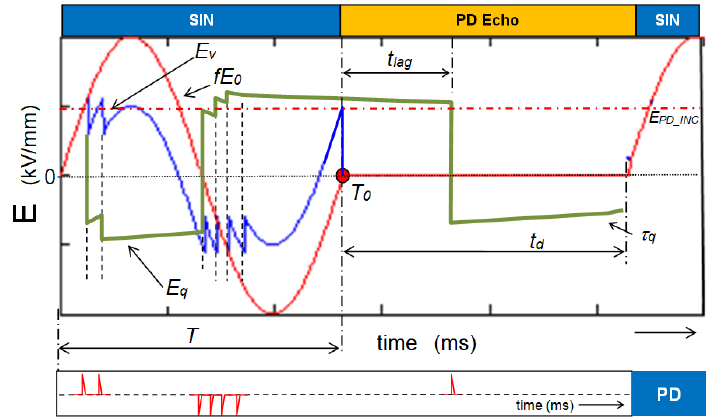
Figure 11. PD Echo mechanism in the non-polar insulating material (glass, remnant field E r not present) .